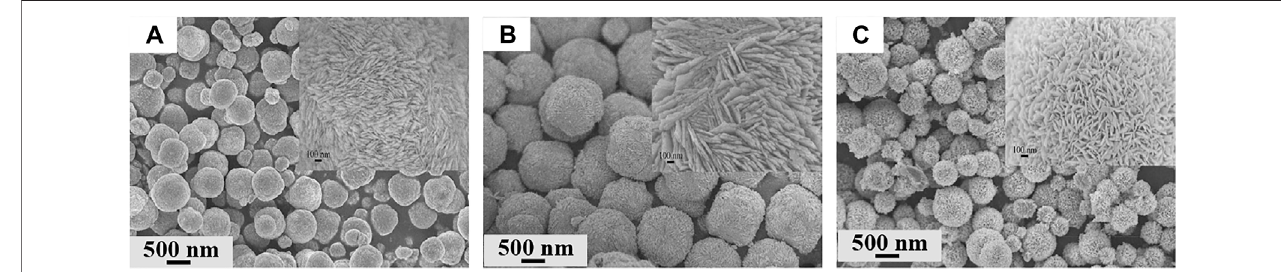
FIGURE 3 | SEM images of BiOCl (A) , BiOBr (B) , and BiOI microspheres (C) (reproduced with permission (Zhang et al.,